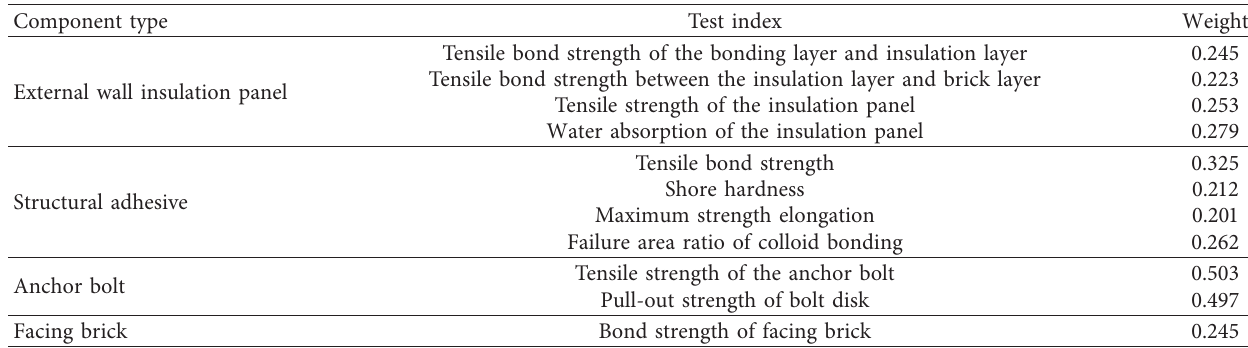
Table 9: Performance test index of building finish layer